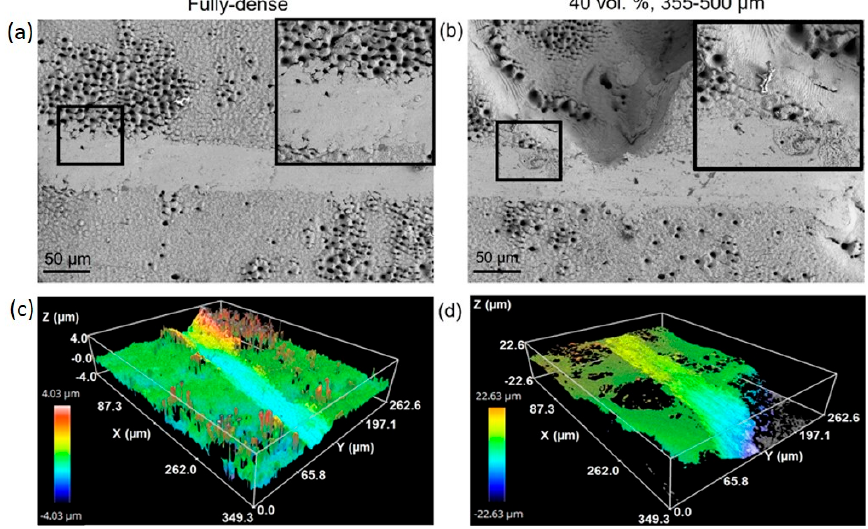
Figure 9. ( a , b ) SEM and ( c , d ) CLM images of scar (due to the scratch test) on fully-dense and porous c.p. Ti substrates. Inset SEM: zoomed details of area marked in subfigures. c.p. Ti substrates. Inset SEM: zoomed details of area marked in